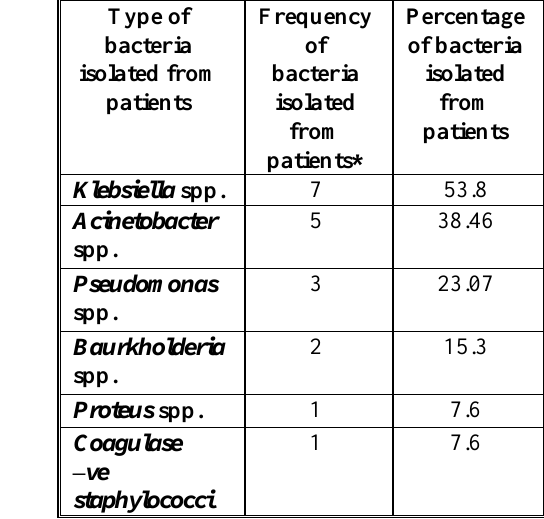
*Six patients have two species of bacteria .